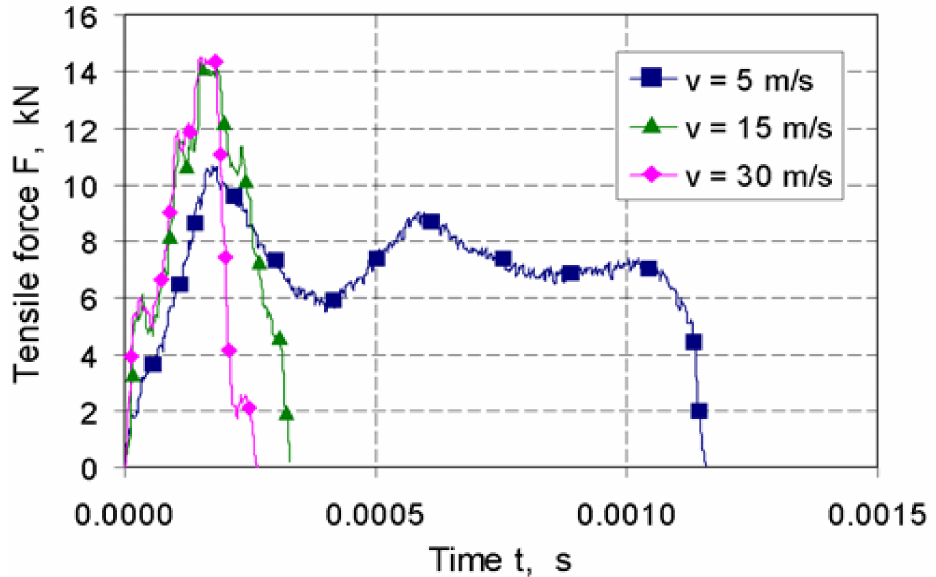
Figure 7. Variation in tensile force with time for TRIP steel at a linear rate of the impact hammer v = 5, 15 and 30 m/s.